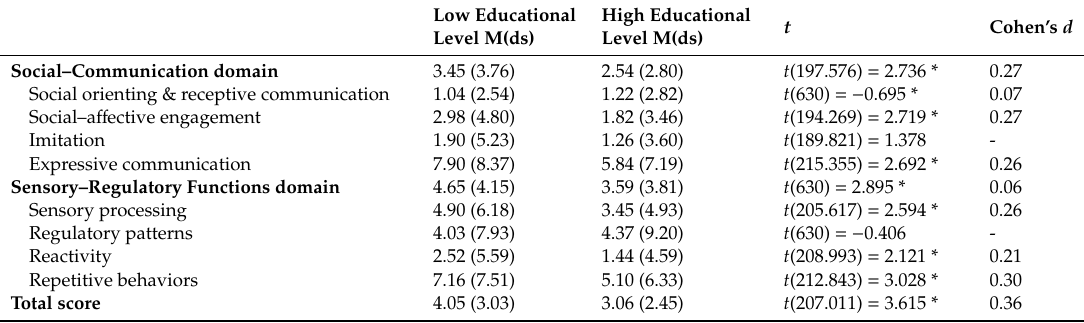
Table 2. Independent-sample t-tests by maternal educational level on the FYI domains, total score, and